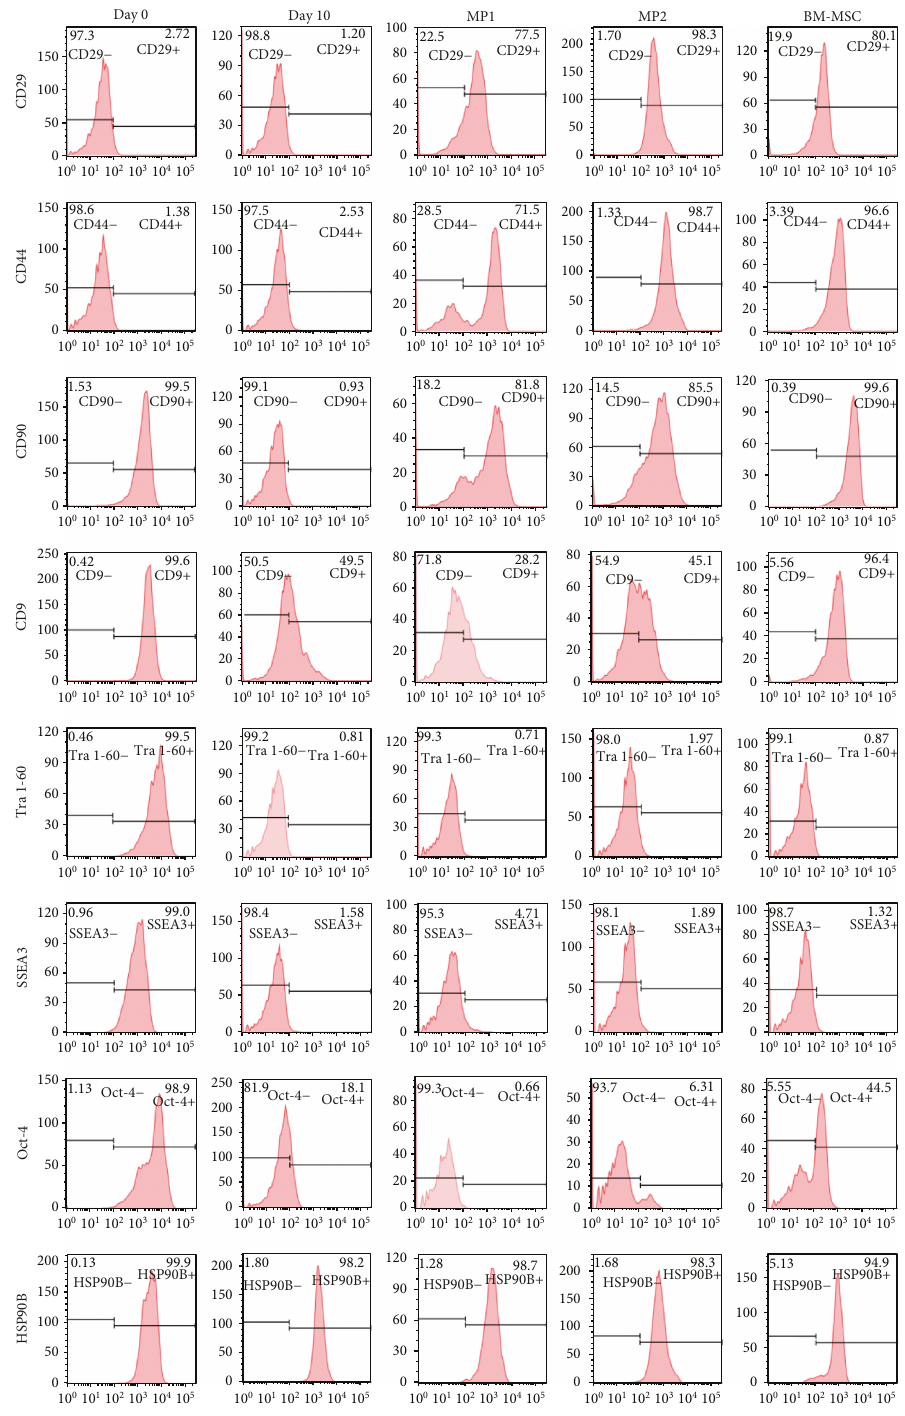
Figure 2: Immunophenotype of iPSCs/ESCs, BM-hMSCs, and iPSC/ESC-derived MSCs before and during the di ff erentiation process. Shown are representative fl ow cytometry histograms of iPSCs/ESCs, BM-hMSCs, and iPSC/ESC-derived MSCs stained for CD44, CD29, CD90, CD9, Tra 1-60, SSEA-3, Oct-4, and HSP90 β